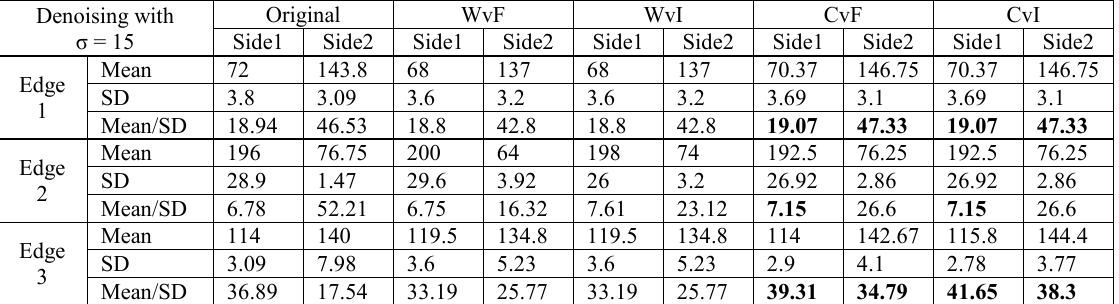
Table 5: Edge preservation capability for Landsat TM image (σ = 15)